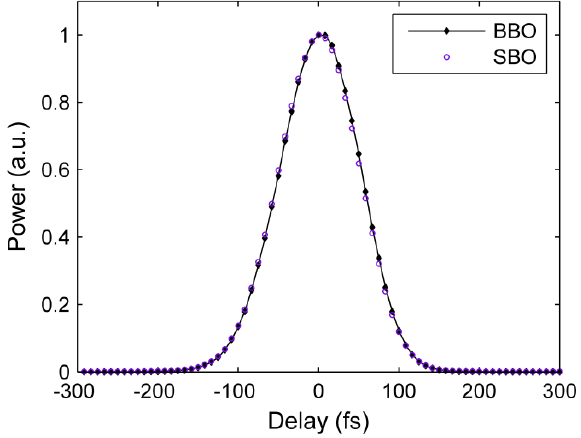
Figure 8. RQPM autocorrelation trace of Tsunami oscillator measured with NPC SBO (blue) and BBO (black). Central wavelength 780 nm. SBO: pulse duration 83.3 fs; power 3.49 microwatts; SNR-2992; BBO: pulse duration 83.7 fs; power 929.9 microwatts; SNR-15079.